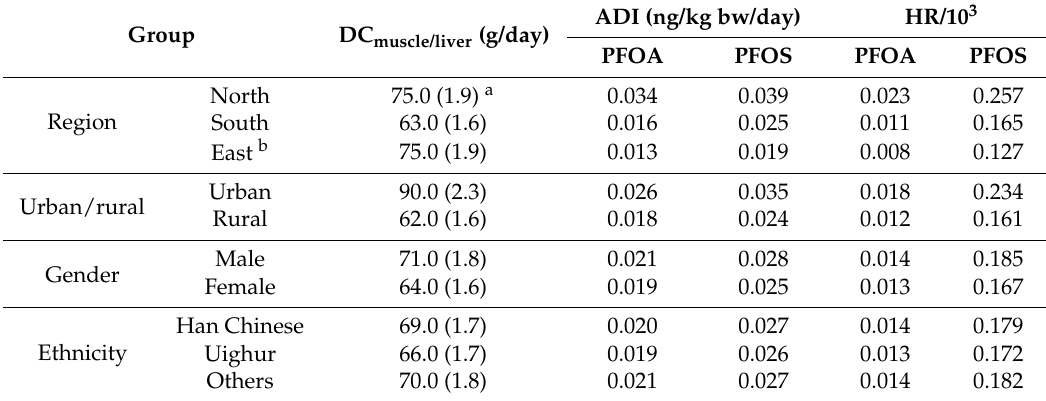
DC muscle/liver : daily consumption values of muscle/liver; ADI: average daily intake; HR: hazard ratios; a muscle (liver); b DC muscle/liver of northern Xinjiang was used.